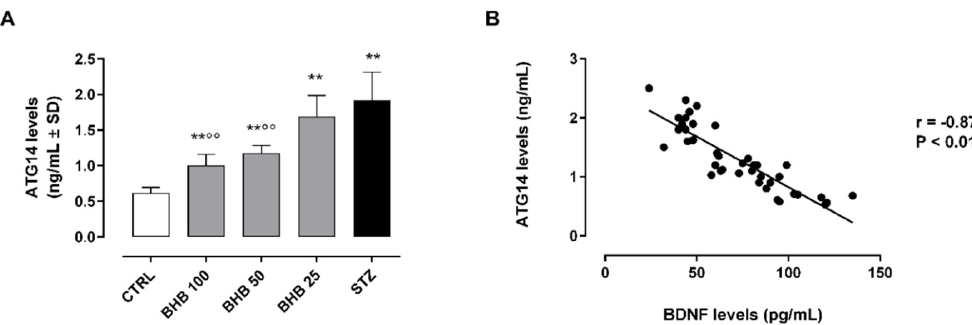
Figure 2. Retinal ATG14 levels ( A ) and their strength of association with BDNF ( B ) in non-diabetic mice (CTRL), diabetic mice (STZ), and diabetic mice treated with BHB 25 mg/kg (BHB 25), 50 mg/kg (BHB 50), and 100 mg/kg (BHB 100). ATG14 levels (ng/mL) are expressed as mean ± SD of N = 8 retinas per group. ** p < 0.01 vs. CTRL; °° p < 0.01 vs. STZ.